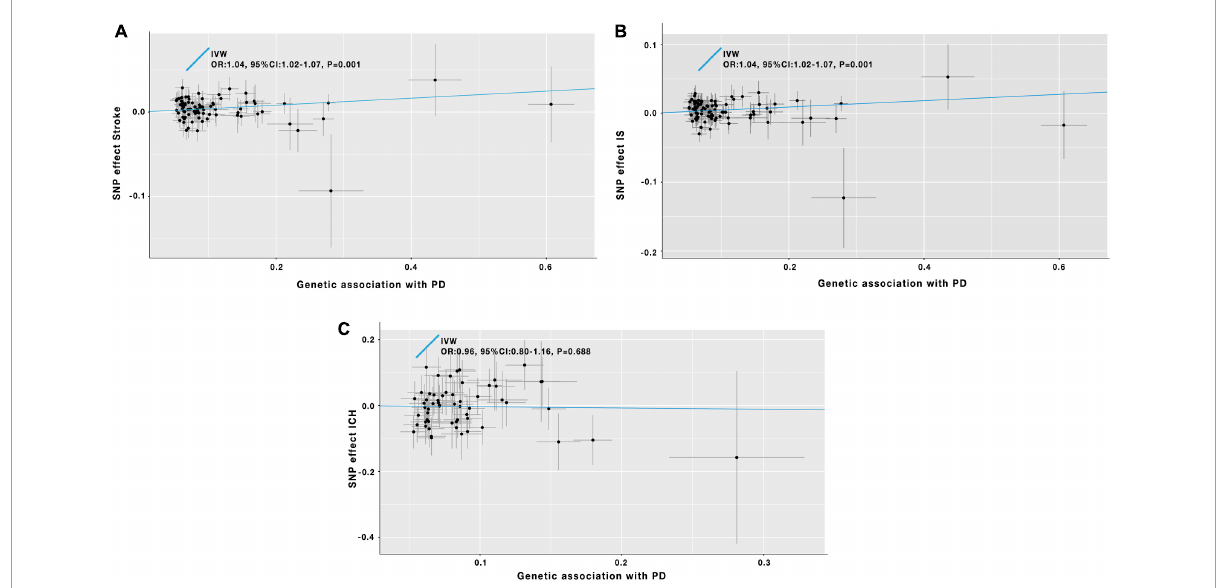
FIGURE3 Scatter plot of the causal effects of PD on the risk of stroke (A) , IS (B) , and ICH (C) . IV, instrumental variable; IVW, inverse-variance-weighted; SNP, single-nucleotide polymorphism; OR, odds ratio; CI, confidence interval; PD, Parkinson’s disease; IS, ischemic stroke; ICH, intracerebral